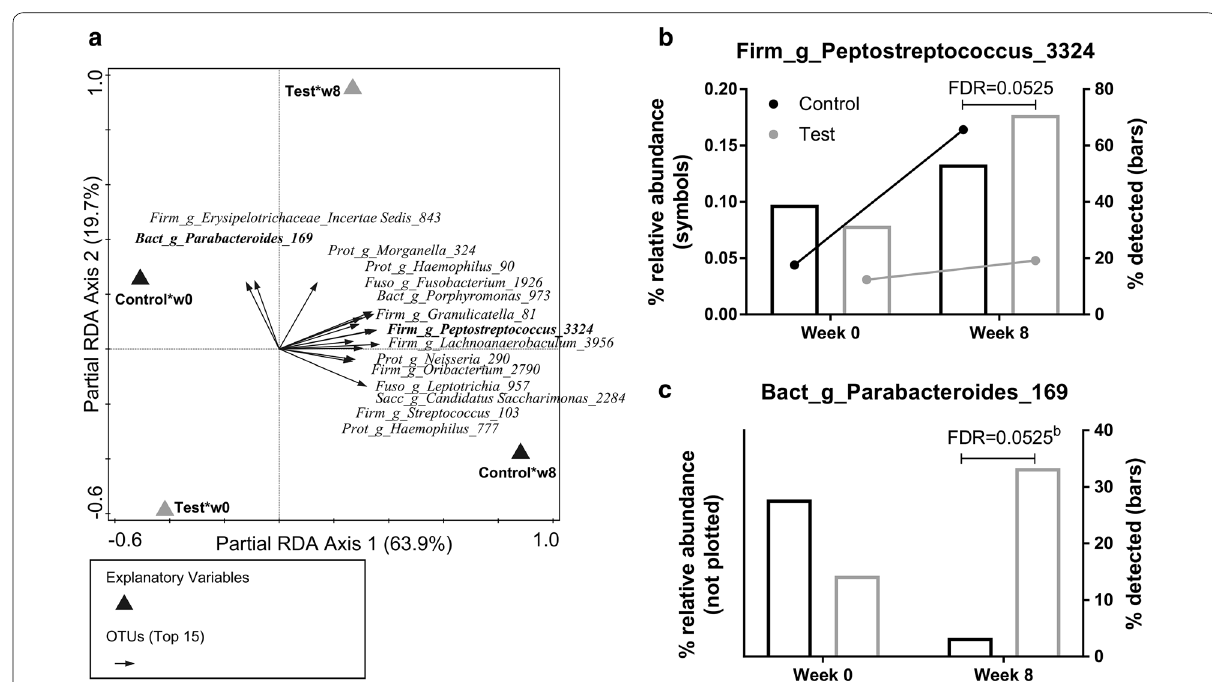
Fig. 3 Redundancy analysis (RDA) biplot showing the change in species composition from week 0 to week 8 in saliva samples of infants receiving test or control formula ( a ). The top 15 OTUs are plotted based on best fit with the first two RDA axes. In bold the OTUs that were significantly different at week 8 between test versus control as confirmed with the two‑part statistics method. The proportion of zeros (plotted as bars) and the median of the non‑zero values (plotted as points) are displayed for the two differentially abundant OTU’s assigned to Peptostreptococcus ( b ) and Parabacteroides ( c ), respectively. False discovery rate (FDR) was used to correct the raw P‑values for multiple testing with significance at 0.1. b Only the Barnard test was performed (if < 5 non‑zeros in one group) to compare the proportion of zeros. The OTU‘s are summarized with unique (but arbitrary) numbers as identifiers, and genus level (“_g_”) and phylum level taxonomic assignments: Acti actinobacteria, Bact bacteroidetes, Firm firmicutes, Fuso fusobacteria, Prot proteobacteria, Sacc